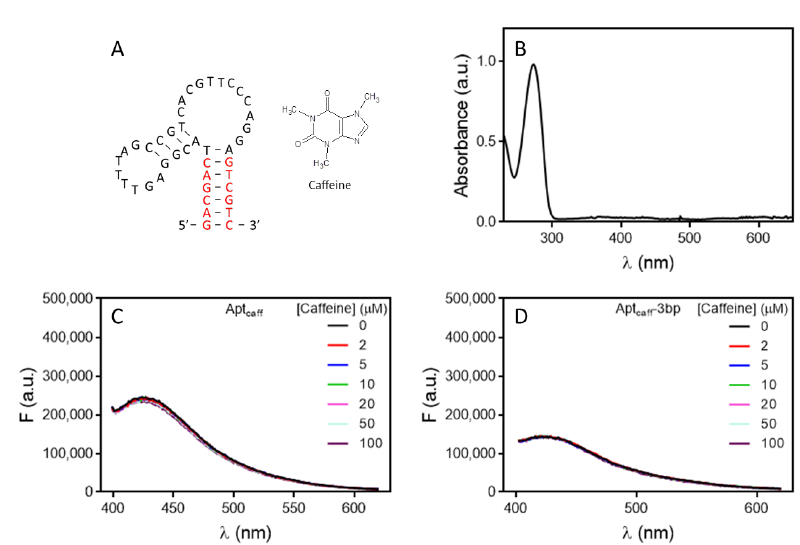
Figure 5. ( A ) The structures of the caffeine aptamer and caffeine. ( B ) UV-vis spectrum of 100 µM caffeine. The fluorescence spectra of the caffeine aptamer with ( C ) 6 bp and ( D ) 3 bp in the stem region upon titration of caffeine.